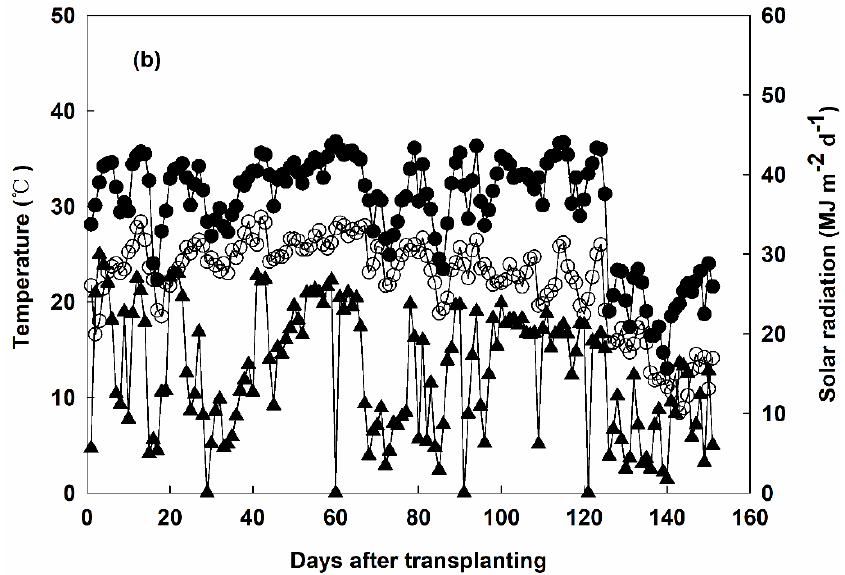
Figure 1. Daily maximal and minimal temperatures, and solar radiation during rice-growing season in Jingzhou in ( a ) 2020 and ( b ) 2021.